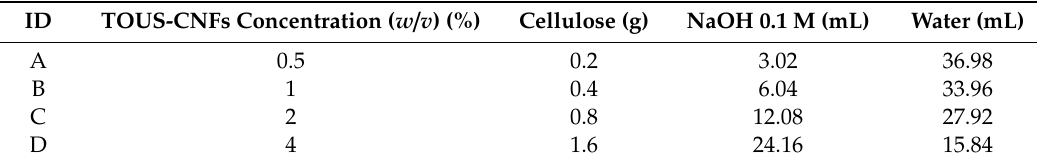
Table 1. Samples of TOUS-CNFs stock dispersions.